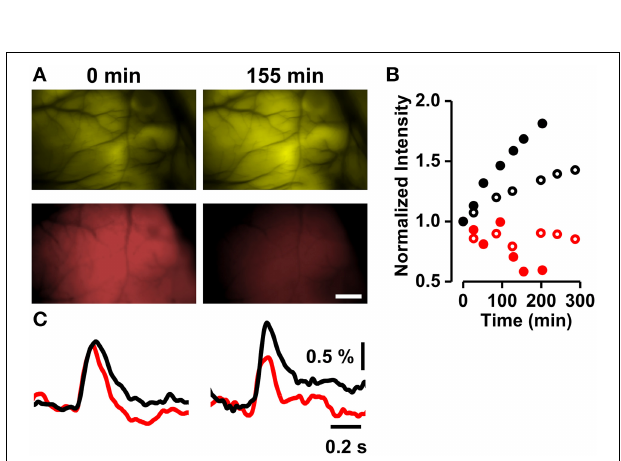
end of the in vivo experiment ( C ; 240 min after washing). The white-dashed outlines indicate the area of craniotomy. Note that VSFP2.3 fluorescence was strongly diminished by the RH1691 stain. Scale bar, 1mm.